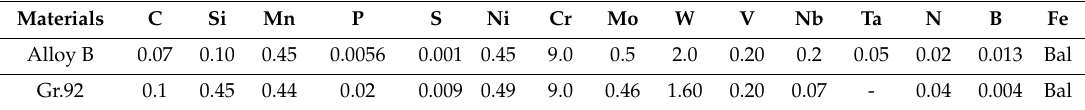
Table 1. Chemical compositions of the alloy B and Gr.92 steel specimens (wt.